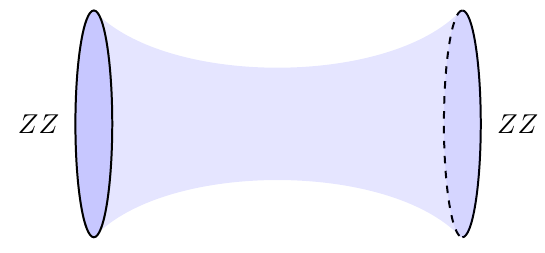
Figure 4 . Geometry of the classical Liouville background between two ZZ